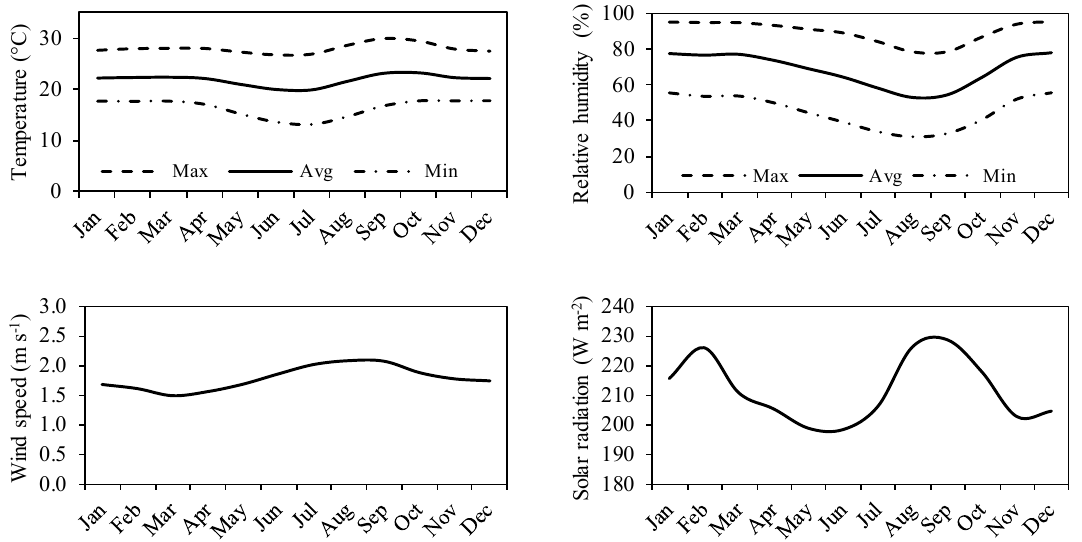
Figure 2. Monthly average climate variables: meteorological station near the reservoir (EM 1 ) for the period from 2010 to 2011.